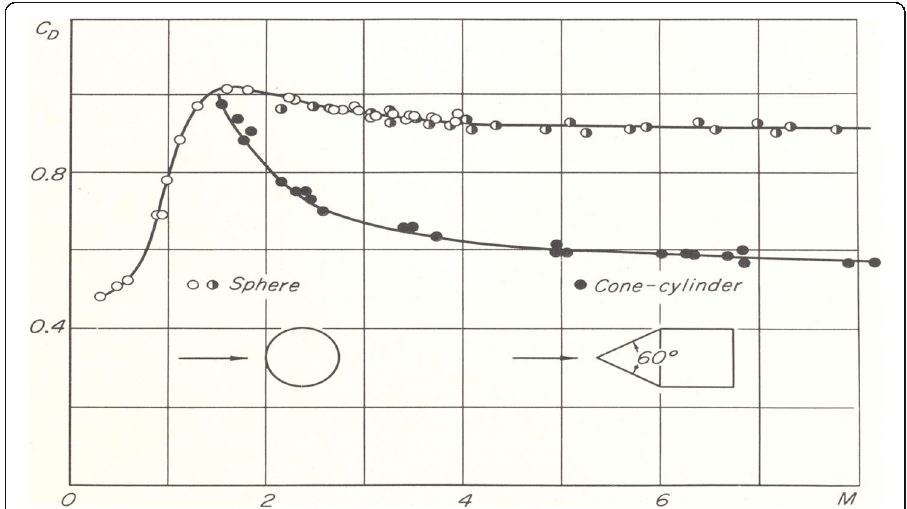
Fig. 1 Mach number independent principle of hypersonic